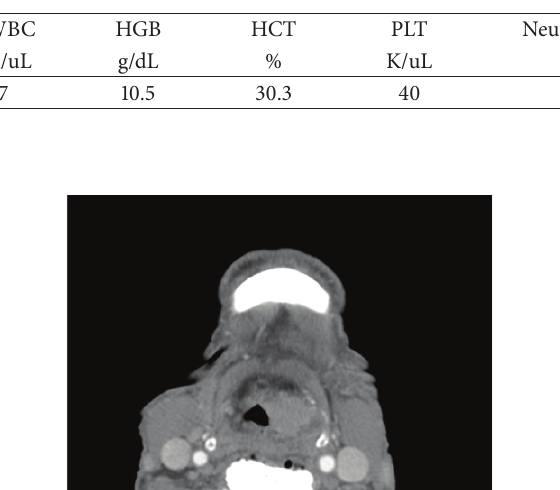
Table 1: Complete blood count from OSH.